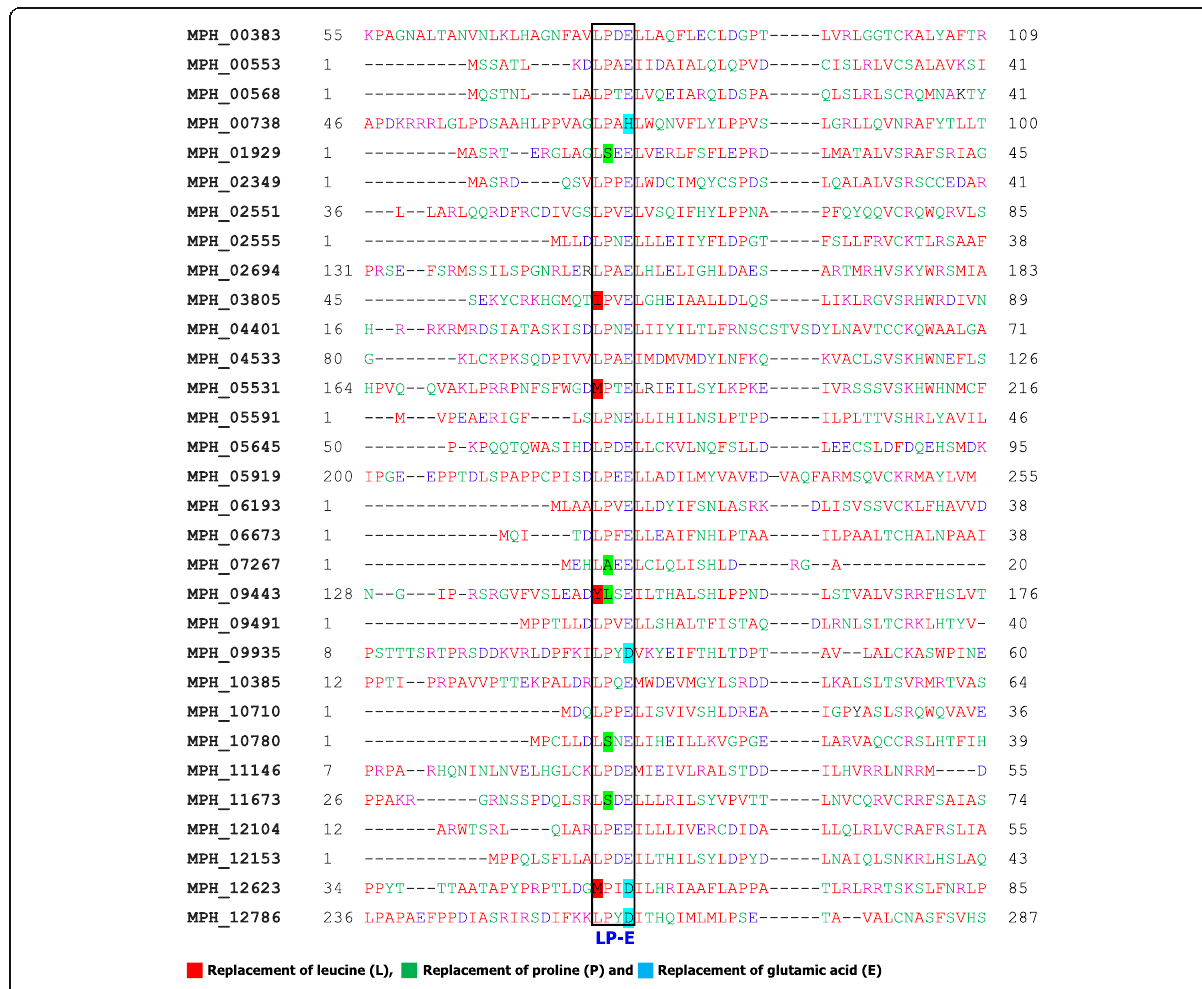
Fig. 3 Sequence alignment of F-box protein in the stem rot fungus M. phaseolina